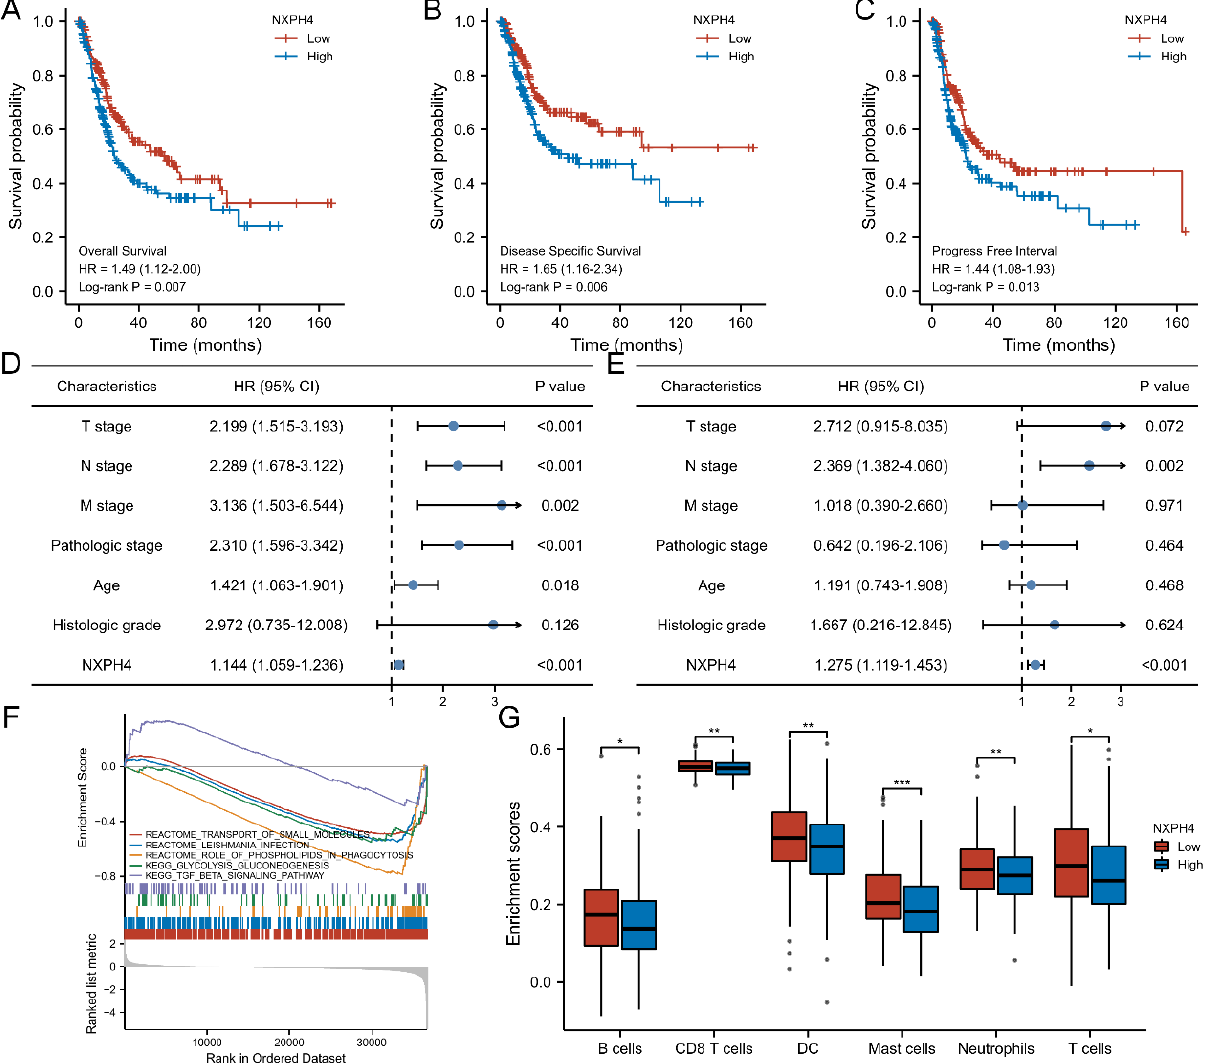
Figure 2. The prognostic value of NXPH4 and its possible mechanism. ( A – C ) Kaplan–Meier analysis for patients with bladder cancer in the fields of overall survival, disease-specific survival, and progression-free interval. ( D , E ) Univariate and multivariate analysis of the influence of some indicators on the overall survival of patients with bladder cancer. ( F ) Gene-set enrichment analysis after dividing groups by NXPH4 expression. ( G ) The relative levels of B cells, CD8 T cells, dendric cells, mast cells, neutrophils, and T cells between patients from the high-NXPH4 group and low-NXPH4 group, * p < 0.05; ** p < 0.01; *** p < 0.001.